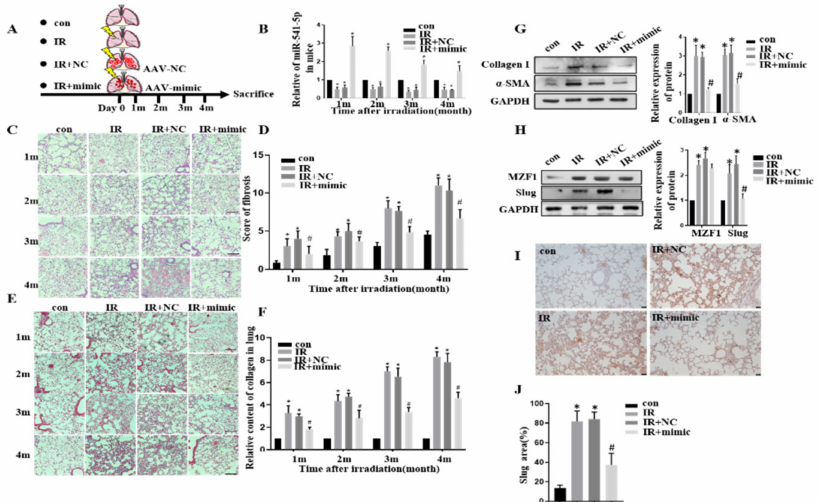
Figure 7. MZF1 mediated the radiation-induced pulmonary fibrosis through the miR-541-5p/Slug axis. ( A ) Diagram depicting the mice grouping. ( B ) Detection of miR–541–5p in mouse lung tissue using RT–qPCR. ( C , D ) H&E staining and scoring of the mouse lung tissue sections (using the semi- quantitative method of lung pathology). The scale bar represents 100 µ m. ( E , F ) Masson’s staining and quantitative analysis of the mouse lung tissue sections (ImagePro Plus). ( G ) Detection of Collagen and α –SMA expression in mouse lung tissue using the Western blot assay. ( H ) MZF1 and Slug expressions in mouse lung tissue determined using the Western blot assay. (I) Slug expression in mouse lung tissue by immunohistochemical experiment. The scale bar represents 10 µ m. ( J ) Quantitative analysis of IHC staining. Data represents the mean ± SEM ( n = 5), * p < 0.05 versus NC of the same group; # p < 0.05 versus IR +